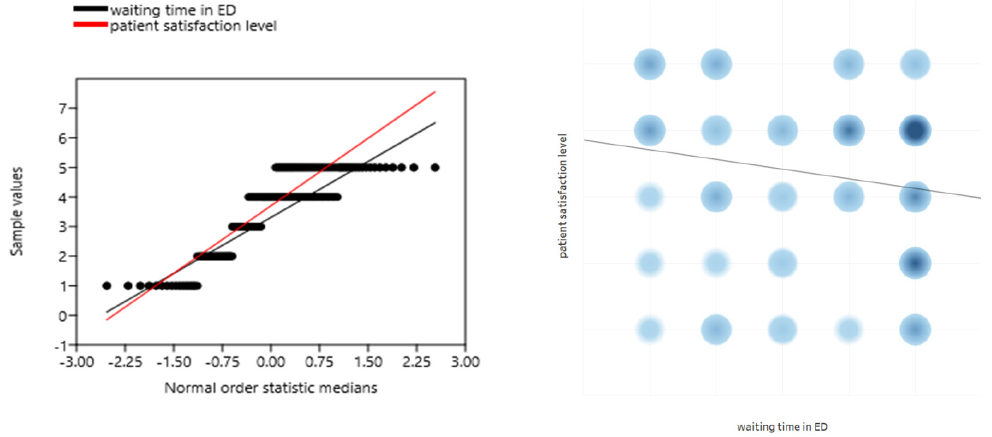
Figure 3 . Correlation of the level of patient satisfaction with the waiting time in the ED. Figure 3. Correlation of the level of patient satisfaction with the waiting time in the